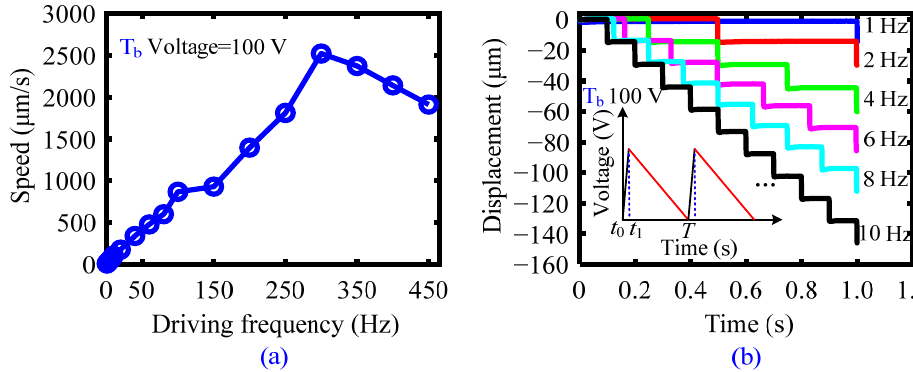
Figure 12. ( a ) Speed change according to driving frequency (1 to 450 Hz) under a fixed driving voltage of 100 V. ( b ) Reverse stepping characteristics of the actuator in the frequency range of 1 to 10 Hz.